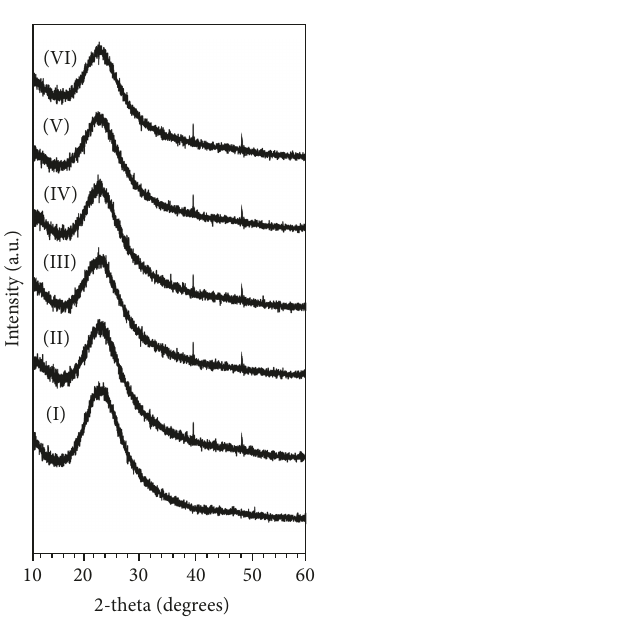
Figure 2: XRD patterns of (I) SiO 2 , (II) SiO 2 @ imineSA, (III) SiO 2 @ imineSB, (IV) SiO 2 @ imineSA-Pd-II, (V) SiO 2 @ imineSB-Pd-II, and (VI) SiO 2 @